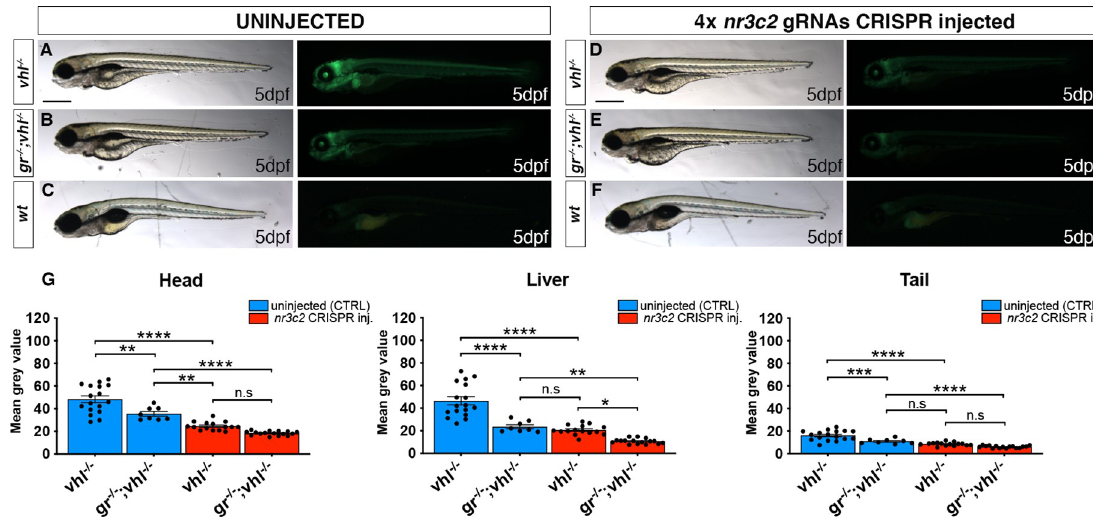
Fig 6. Both Gr and Mr are directly required in the HIF signalling pathway. A-F. Representative pictures of 5 dpf CRISPANT mutants created by redundantly targeting nr3c2 ( mr ) gene via co-injection of 4x gRNAs in gr +/- ;vhl +/- ( phd3 : eGFP ) x gr -/- ; vhl +/- ( phd3 : eGFP ) derived embryos (n = 344). Uninjected embryos were used as control (n = 170). Fluorescence, exposure = 991,4 ms. Scale bar 500 μ m. G. Statistical analysis performed on mean grey value quantification (at the level of the head, liver and tail), after phenotypic analysis, on 5 dpf mr 4x gRNAs injected and uninjected larvae. vhl -/- uninjected n = 17 larvae: head 48.28 ± 2.99 (mean ± s.e.m); liver 46.47 ± 3.55 (mean ± s.e.m); tail 16.15 ± 1.06 (mean ± s.e.m). gr -/- ;vhl -/- uninjected n = 8 larvae: head 35.48 ± 2.03 (mean ± s.e.m); liver 23.56 ± 1.72 (mean ± s.e.m); tail 10.98 ± 0.75 (mean ± s.e.m). vhl -/- injected n = 15 larvae: head 24.62 ± 0.97 (mean ± s.e.m); liver 20.67 ± 1.1 (mean ± s.e.m); tail 8.57 ± 0.39 (mean ± s.e.m). gr -/- ;vhl -/- injected n = 16 larvae: head 18.33 ± 0.46 (mean ± s.e.m); liver 10.71 ± 0.56 (mean ± s.e.m); tail 6.07 ± 0.26 (mean ± s.e.m); ordinary One-way ANOVA followed by Sidak’s multiple comparison test.